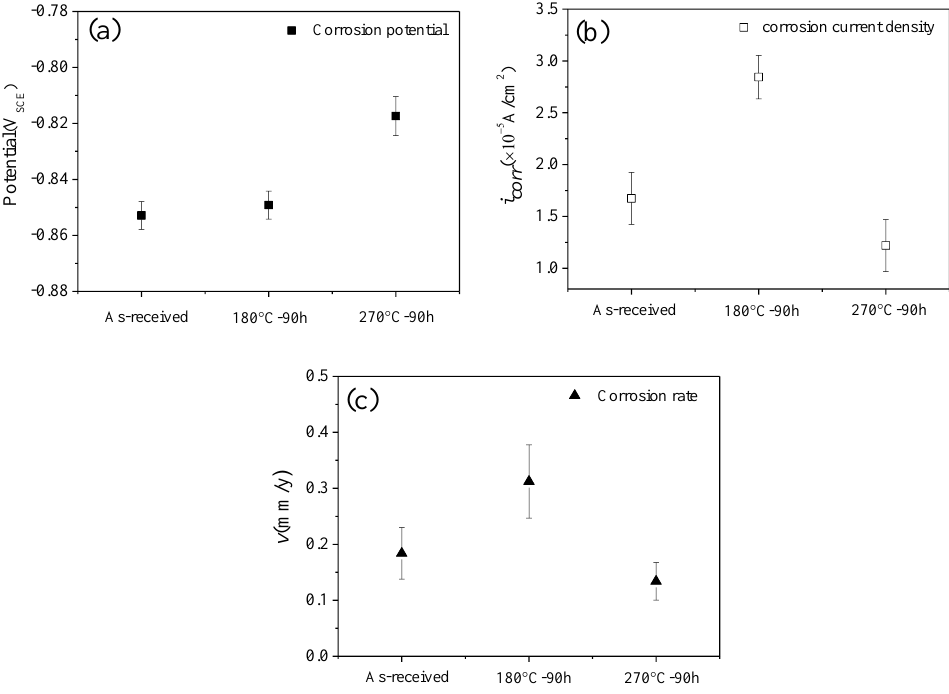
Figure 6. Effects of thermal exposure parameters on the corrosion properties of the studied alloy: ( a ) the corrosion potential; ( b ) the corrosion current density; ( c ) the corrosion rate.